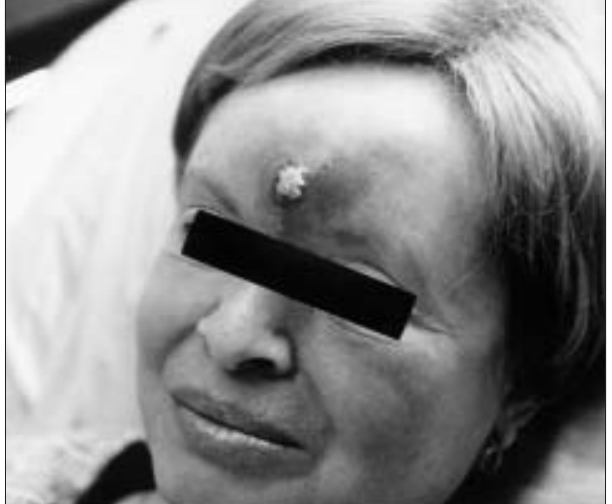
Figure 1) Midfrontal lesion, Pott’s puffy tumour (postincision and drainage).Normalsalinepackingisvisibleinthecentreofthelesion